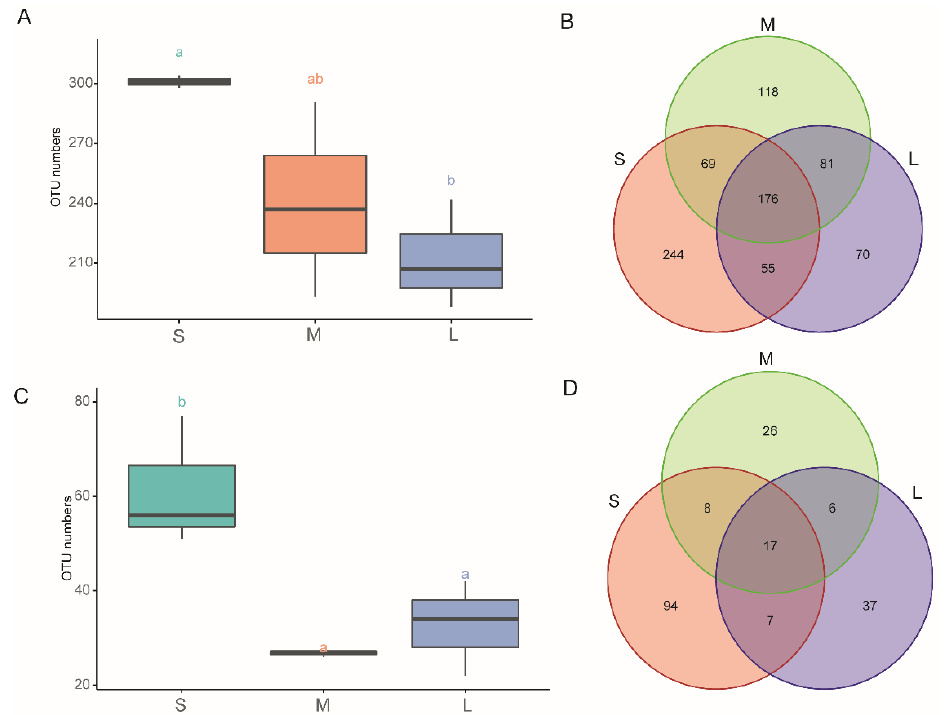
Figure 2. OTU numbers and Venn analysis of exclusive and shared Operational Taxonomic Units (OTUs) in different samples. ( A ) Number of OTUs in the bacterial community; ( B )Venn diagram of the bacterial community; ( C ) number of OTUs in the fungal community; ( D ) Venn diagram of the fungal community. S, M, and L represent the seedling stage, vegetative growth stage, and reproductive growth stage of Paphiopedilum armeniacum , respectively. Lowercases a and b in the graphs indicate significant differences between the different samples, determined using Tukey’s test ( p < 0.05).